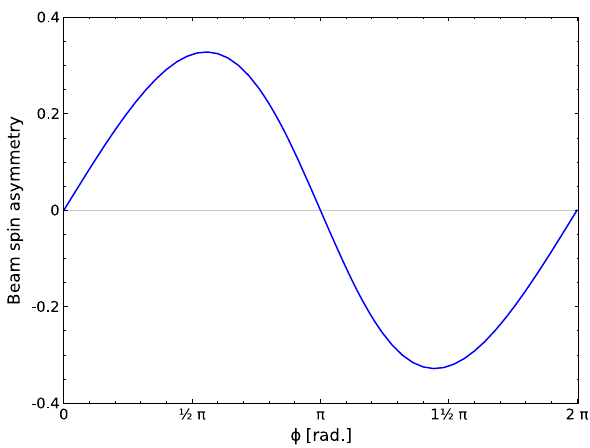
(φ) for x = 1 / 3 , t = − 0 . 2 GeV 2 , B LU